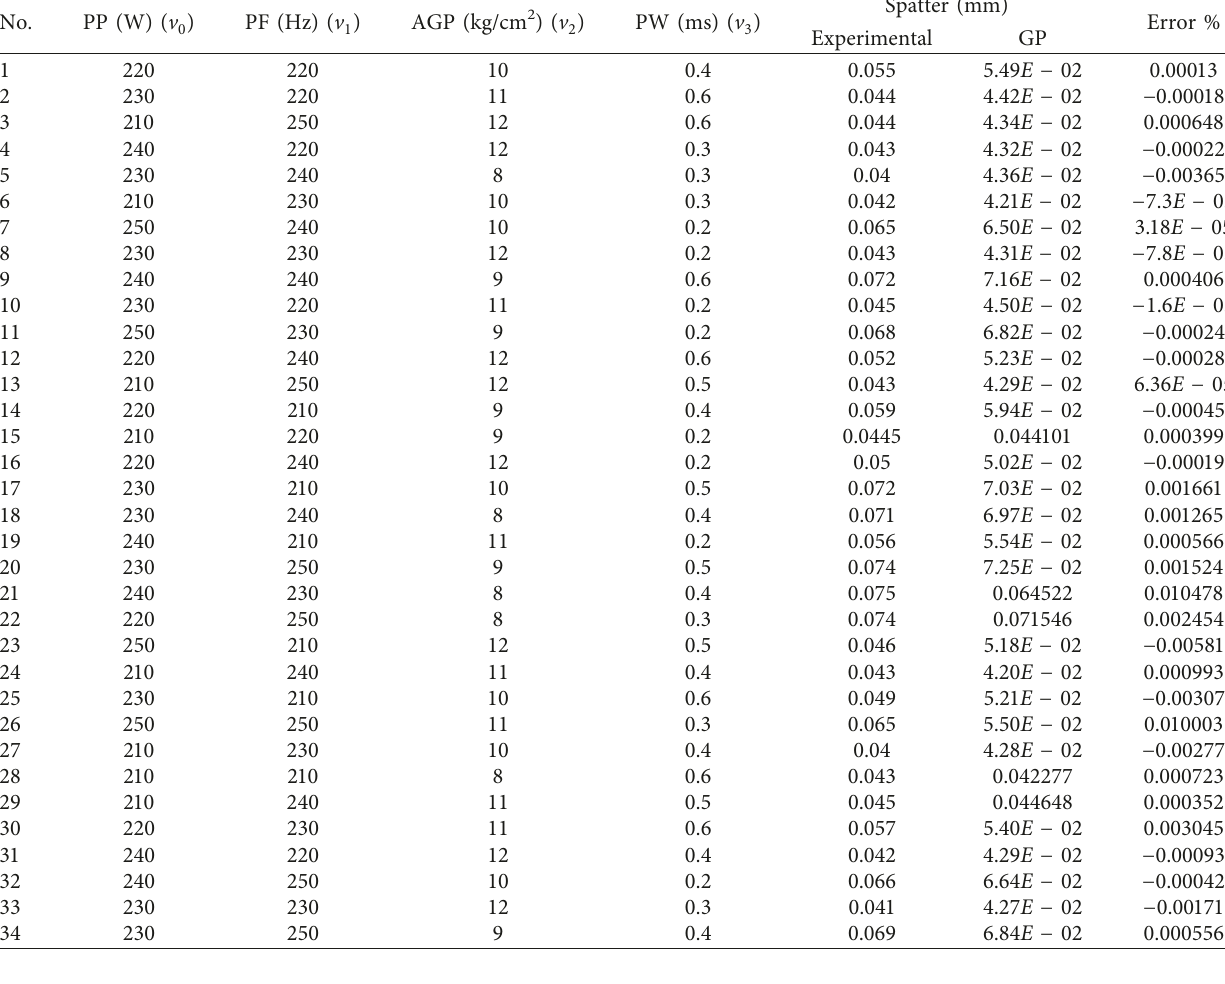
Table 5: Comparison between experimental and predicted values of spatter at R 2 �